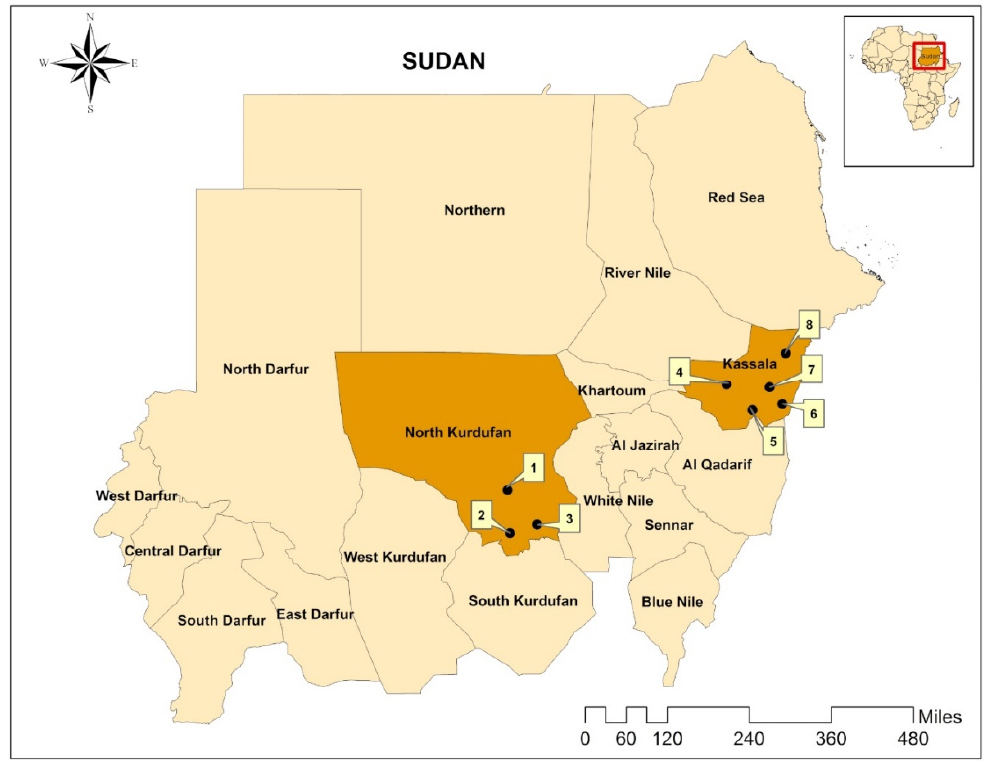
Figure 1. Map showing the location of Sudan in Africa (small map) and the location of the study areas in Sudan (North Kordofan and Kassala states, indicated by orange). Sampling was conducted in Sheikan (1), Al-Rahad (2), Um-Ruwabah (3), West Kassala (4), Kashm el Griba (5), Kassala (6), Aroomah (7) and Wagar (8). The map was created using ArcGIS v. 10 (esri Inc., Redlands, CA, USA).